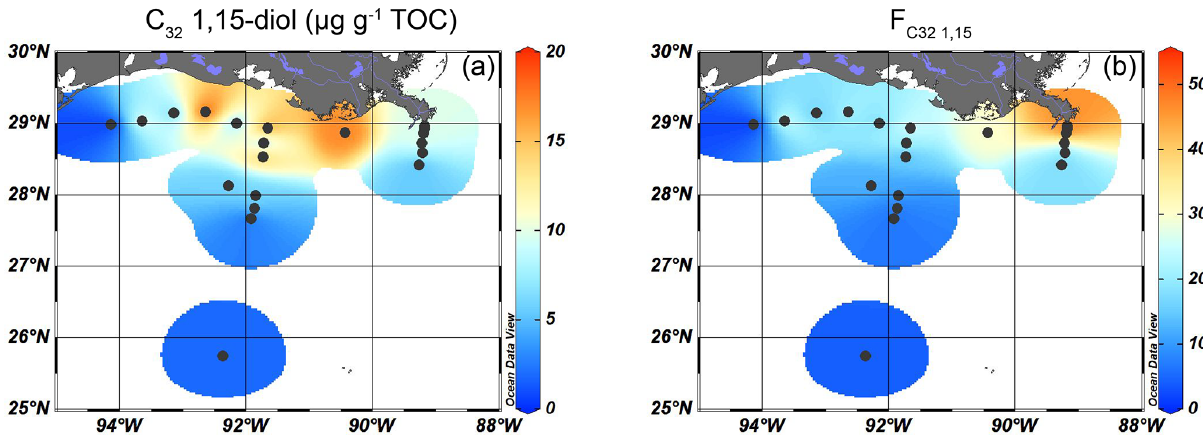
Figure 5. Isosurface plots of proxies for fluvially discharged freshwater TerrOM input for surface sediments in the GoM: (a) the concentration of C 32 1,15-diols (µgg − 1 TOC) and (b) the F C index. 32 1 , 15